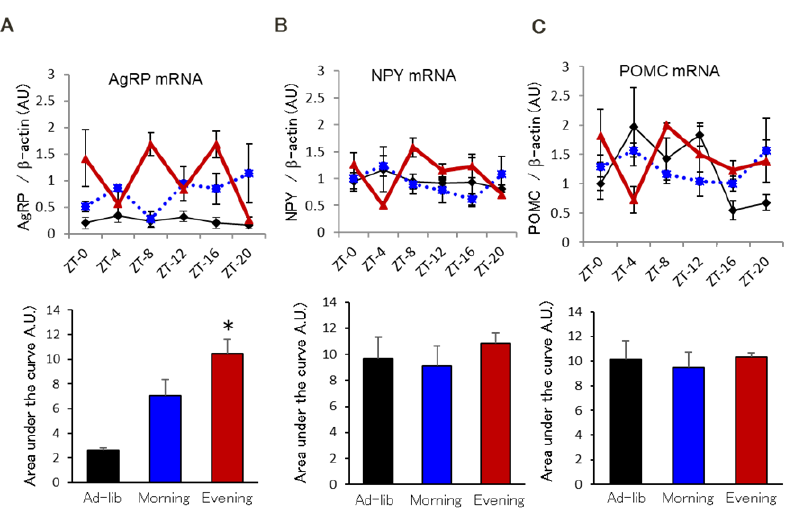
Figure 3. AgRP is a candidate for the evening feeding rhythm-induced insulin resistance. Real time quantitative PCR in 24-h ( n = 3 – 4). ( A ) AgRP ( B ) NPY ( C ) POMC. Red, blue, and black lines represent the Evening, Morning, and Ad-lib groups, respectively. Bottom panel shows the area under the curve of each gene mRNA circadian expression. * p < 0.05 vs. Ad-lib group.